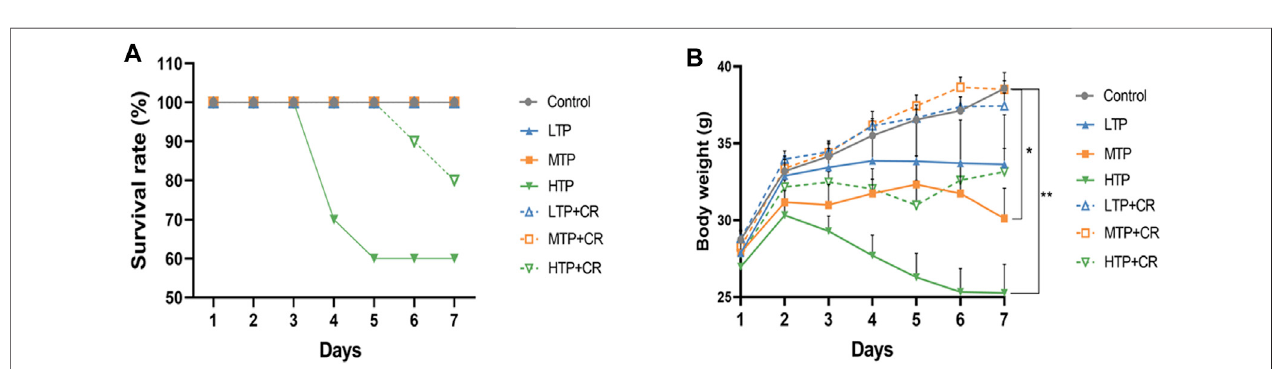
FIGURE 7 | The survival rates (A) (n = 10) and body weight changes (B) (n = 6) of different groups over 7 days * p < 0.05, ** p < 0.01 vs Control.